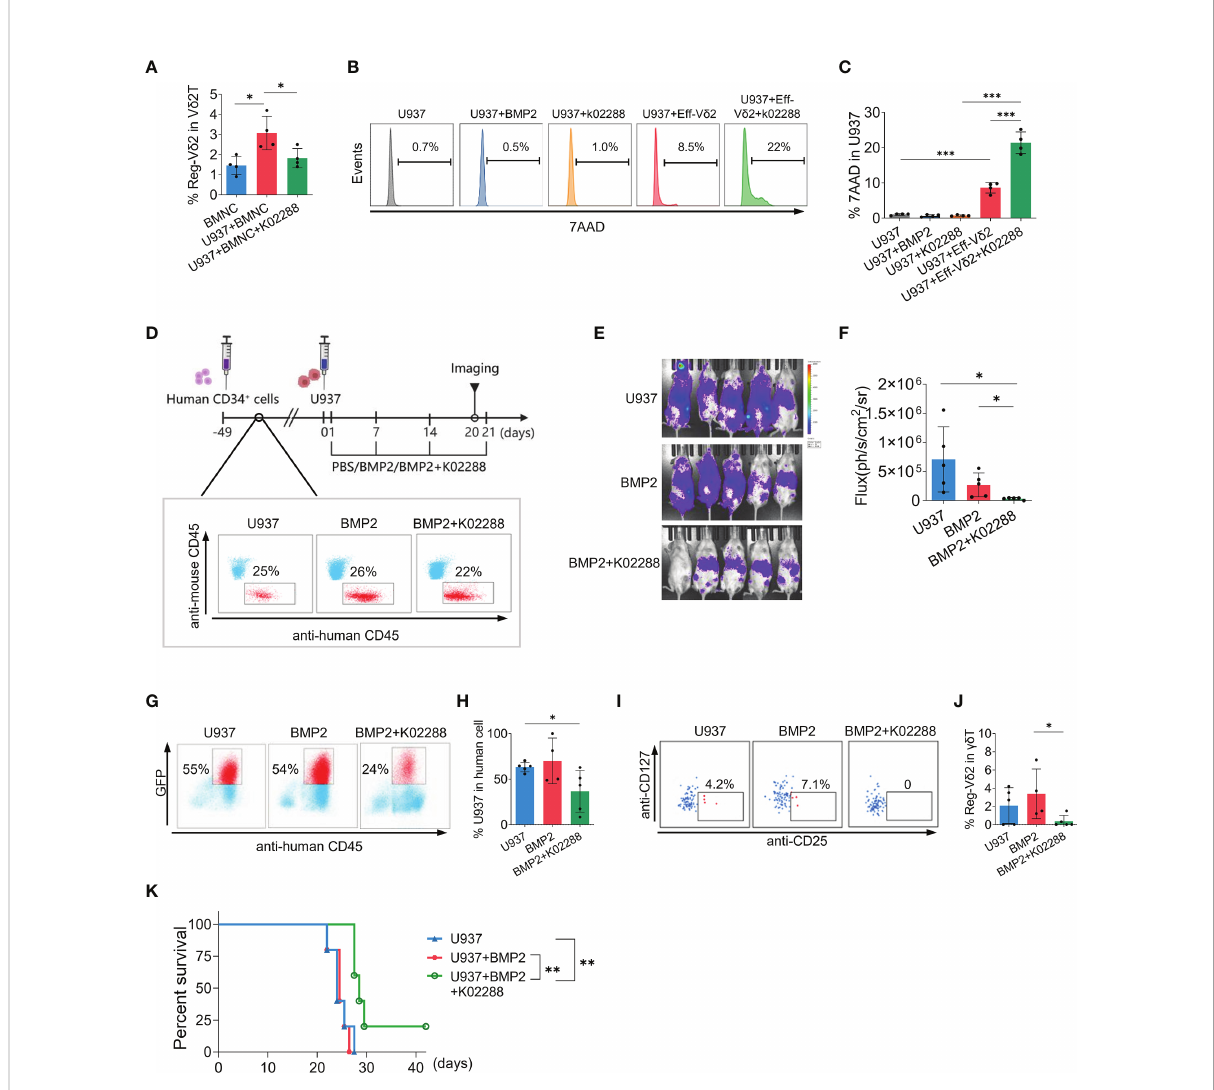
FIGURE 6 Effect of BMP-pathway inhibitor on the emergence of Reg-V d 2 cells and the elimination of AML cells in humanized mice. (A) Bone marrow mononuclear cells (BMNCs) isolated from healthy donors were co-cultured with U937 cells, with or without an inhibitor of BMP receptor (k02288, 5 m mol/L). The frequencies of Reg-V d 2 cells were detected by fl ow cytometry. n = 4, * P < 0.05. Representative histograms of fl ow cytometry (B) and the statistical analyses (C) for 7-AAD positive fractions in U937 cells among the indicated groups. n = 4, *** P < 0.001. (D) Protocol for evaluating the impact of k02288 on the anti-AML activity in humanized mice. NPG mice were initially injected with human CD34 + cells. Following implantation, U937 cells co-expressing luciferase and GFP, and BMP2 with or without k02288 were injected at indicated time points. Noninvasive whole-body imaging for the growth of U937 cells (E) and quanti fi cation of bioluminescence signal (F) among different groups on day 20. Representative dot-plot images of fl ow cytometry and the statistical analyses showing the frequencies of U937 cells (G, H) and Reg-V d 2 cells (I, J) in the bone marrows of mice with different treatments. (K) Survival of mice with different treatments until 42 days. (D – K) n = 5, * P < 0.05, ** P <